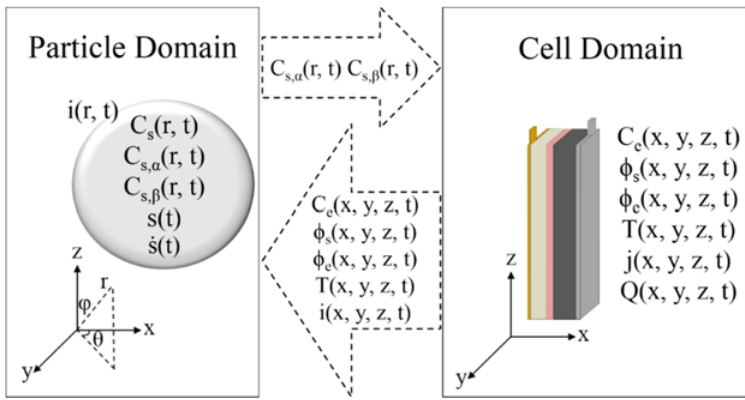
Figure 2. Micro ‐ and macro ‐ scale computational domains of a LIB cell and the coupling variables Figure 2. Micro- and macro-scale computational domains of a LIB cell and the coupling variables exchanged during multiscale simulations. exchanged during multiscale simulations.